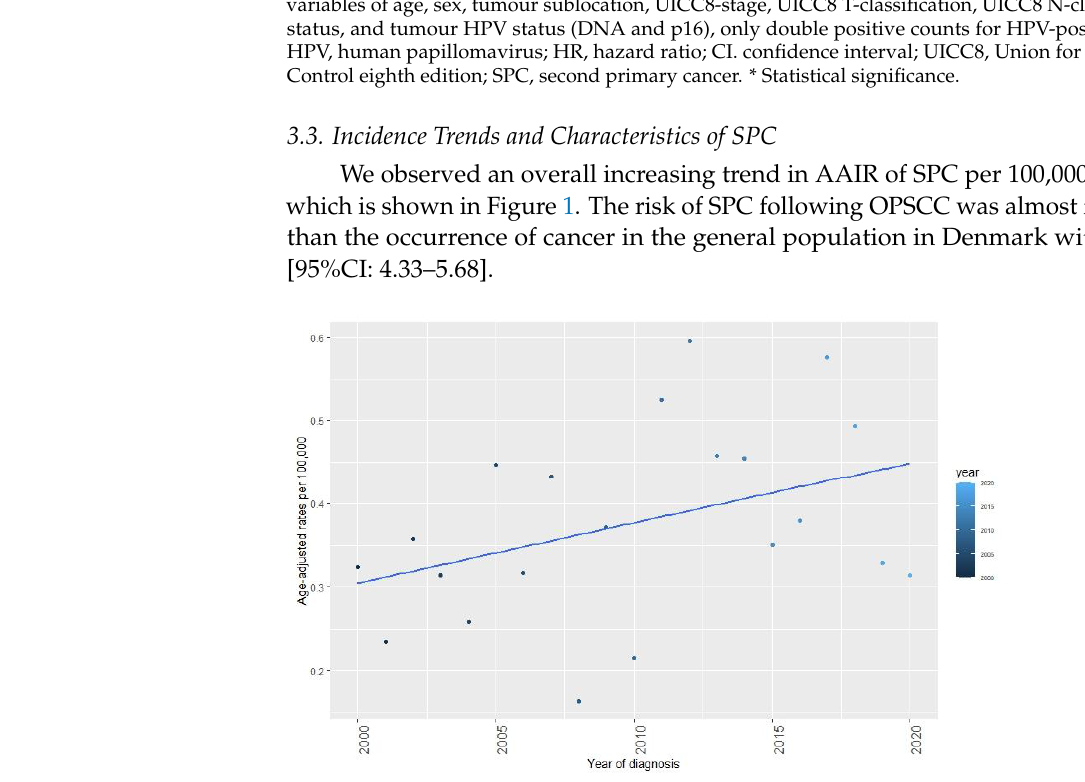
Figure 1. Age-adjusted incidence rates (AAIR) per 100,000 of SPC following treatment of OPSCC in Eastern Denmark from 2000 – 2020. The total incidence of SPC showed an overall increase through the period 2000 to 2020.